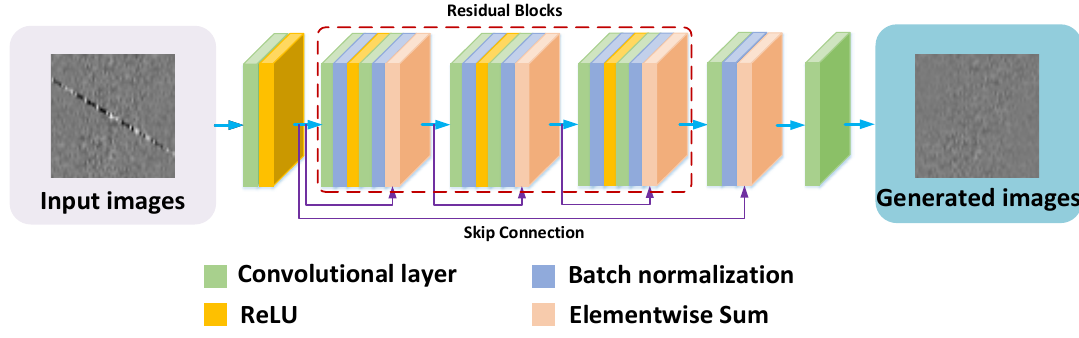
Figure 5. The interference mitigation network (IMN) framework.